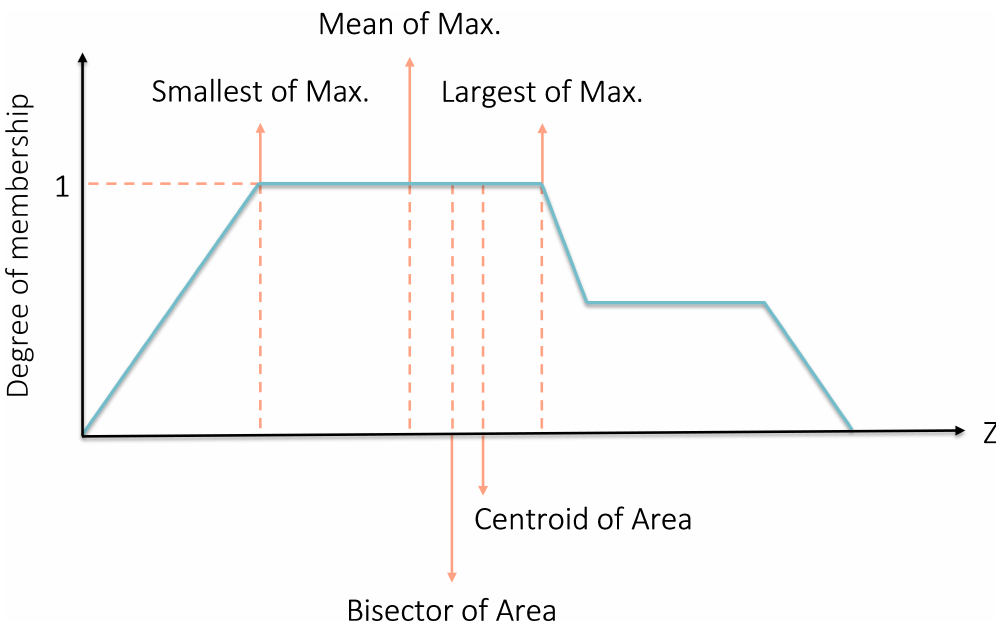
Figure 15. Defuzzification